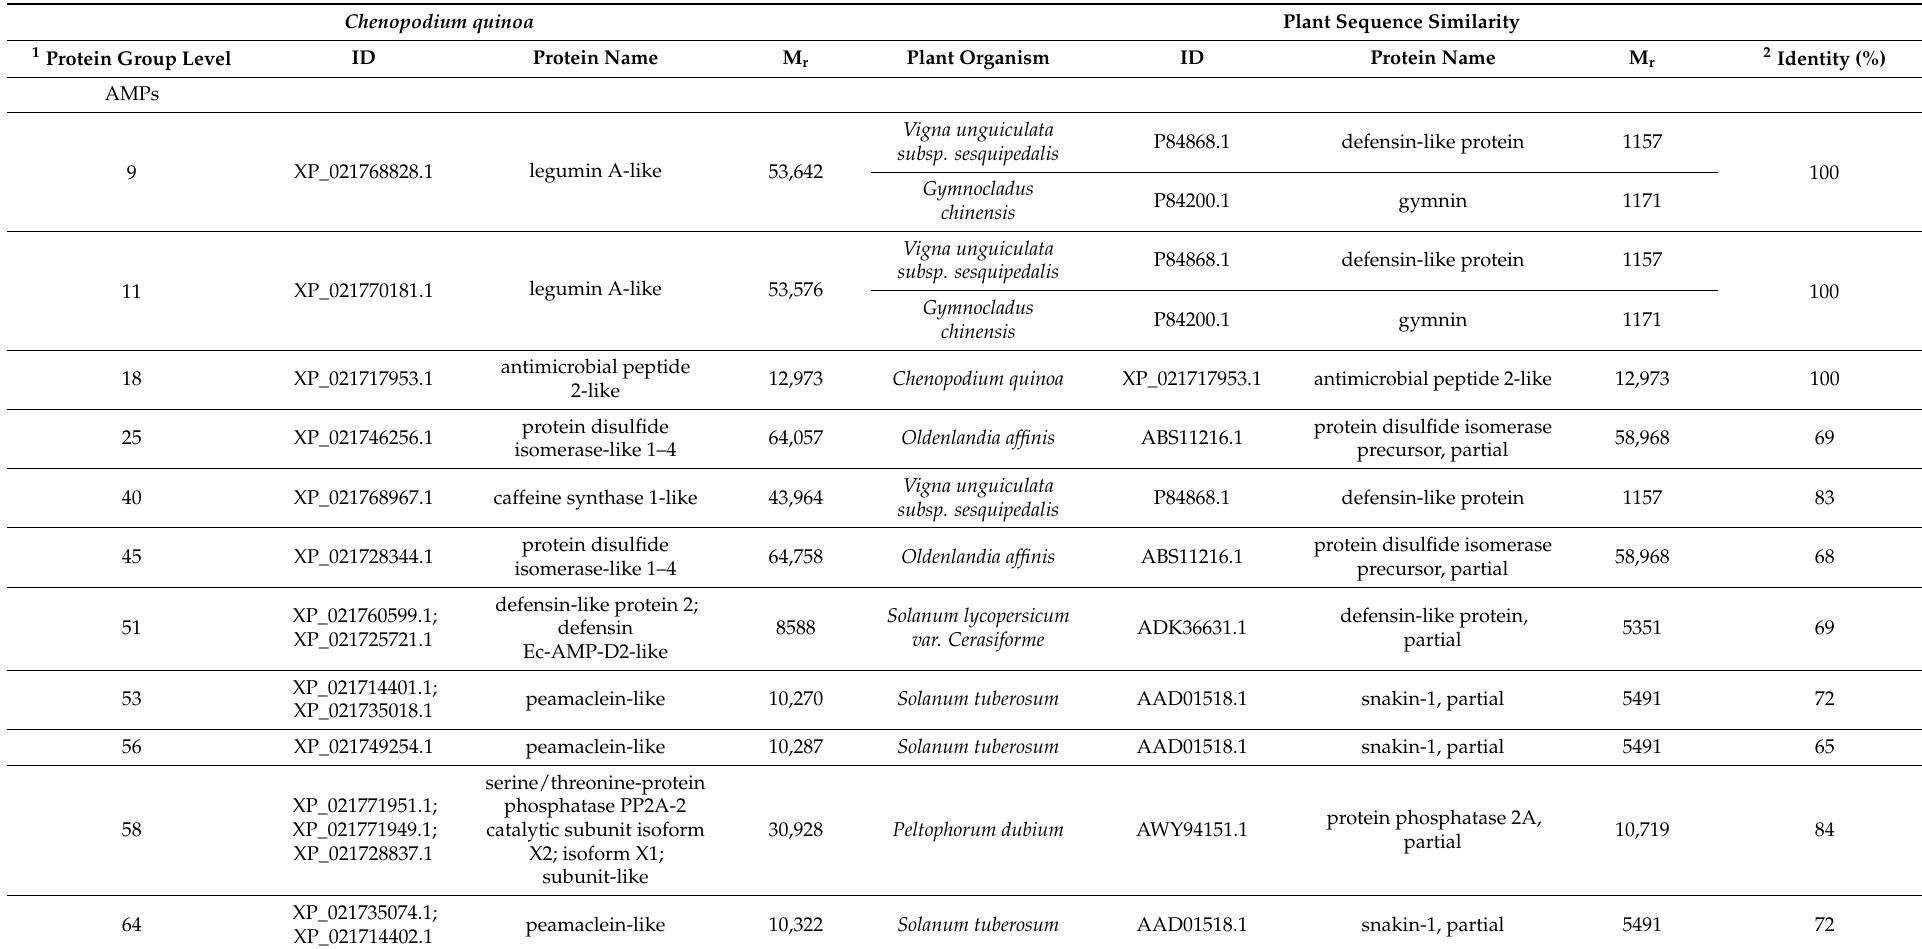
Table 1. Protein group level, NCBI accession number (ID), protein name, relative molecular mass (M r ), and plant sequence similarity for the 13 AMPs and 11 OSIPs identified with an identity ≥ 65% (threshold selected to increase the significance of the interpretation). Chenopodium quinoa Plant Sequence